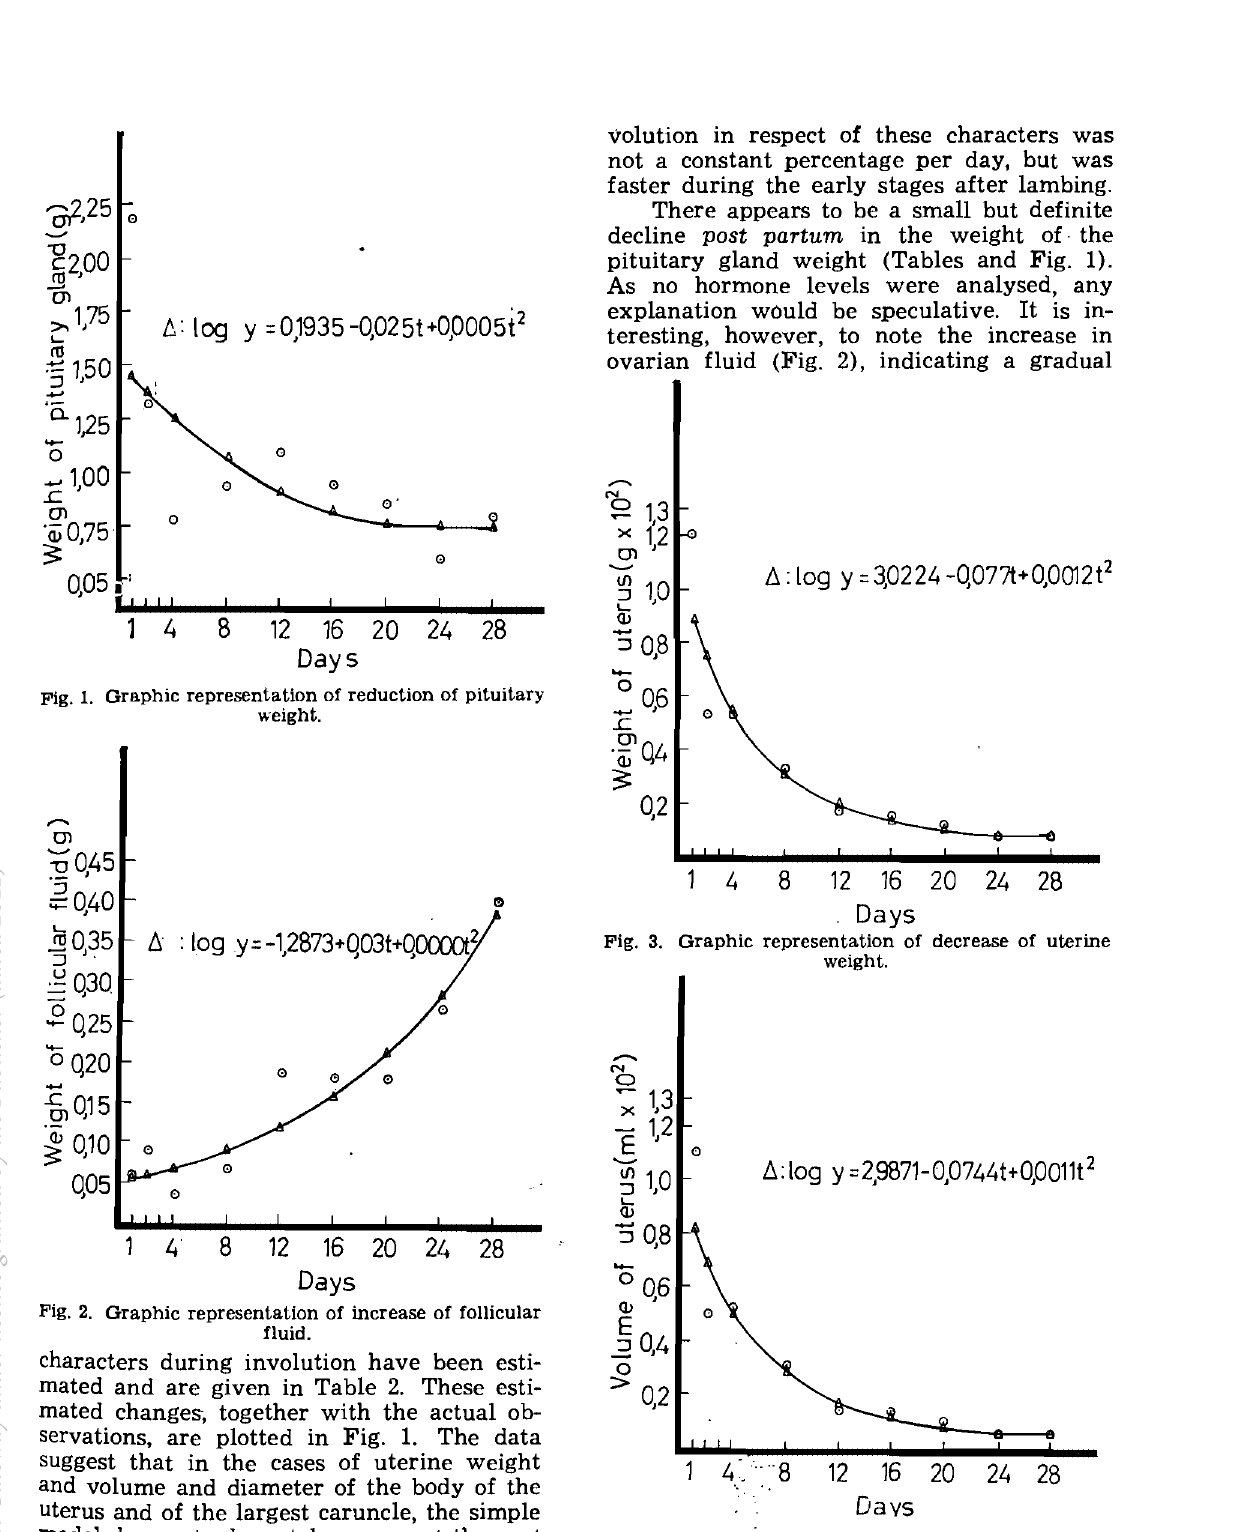
Fig. 2. Graphic representation of increase of follicular fluid. characters during involution have been esti mated and are given in Table 2. These esti mated changes', together with the actual ob servations, are plotted in Fig. 1. The data suggest that in the cases of uterine weight and volume and diameter of the body of the uterus and of the largest caruncle, the simple model does not adequately represent the post Fig 4. Graphic representation of decrease of uterine partum changes which occurred, and that in- 31